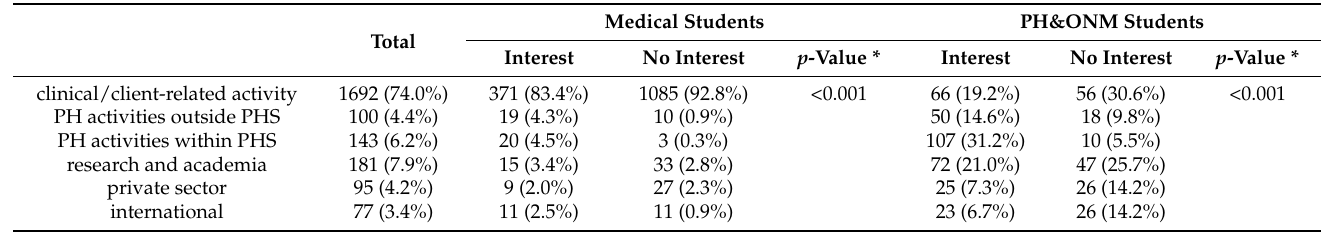
Table A1. Preferred fields of activity after graduation: Absolute and relative proportion of the fields of activity with the highest priority by field of study and PHS interest in wave 1, OeGD-Studisurvey.